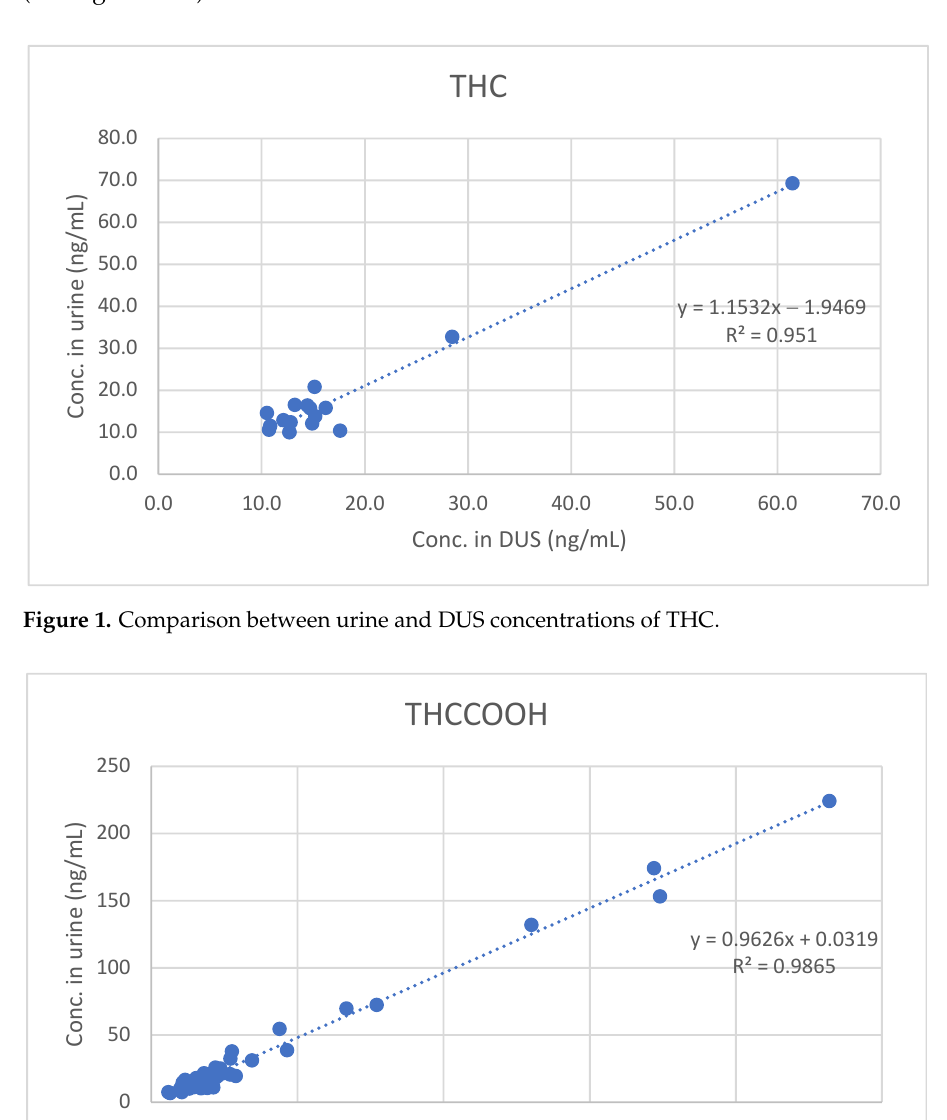
y = 1.1532x − 1.9469 R² = 0.951